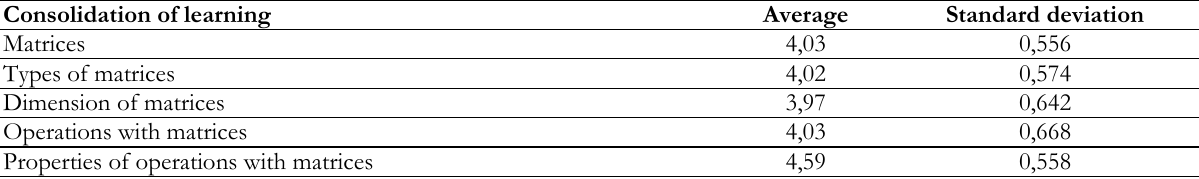
Table 4. Interest and motivation of practical project Consolidation of